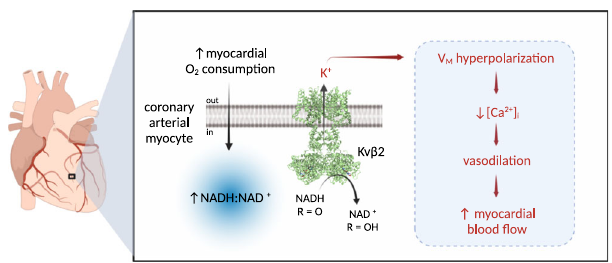
Fig. 6 Oxygen demand-sensitive coronary arterial myocyte NADH:NAD + links blood fl ow to myocardial metabolism via Kv β 2 catalytic function. Schematic representation showing proposed model of myocardial blood fl ow regulation via coronary pyridine nucleotide redox potential. Increases in myocardial oxygen consumption and cardiac workload promote the rapid elevation of intracellular NADH:NAD + in arterial myocytes in the wall of intramyocardial coronary arteries. This change in redox balance modulates the voltage-sensitivity of Kv1 gating via binding and enzymatic oxidation of NADH by Kv-associated Kv β 2 proteins. Resultant enhancement of steady- state K + ef fl ux leads to membrane potential (V M ) hyperpolarization, reduction in intracellular [Ca 2 + ] I , arterial myocyte relaxation, and vasodilation, thus increasing blood fl ow. Created with